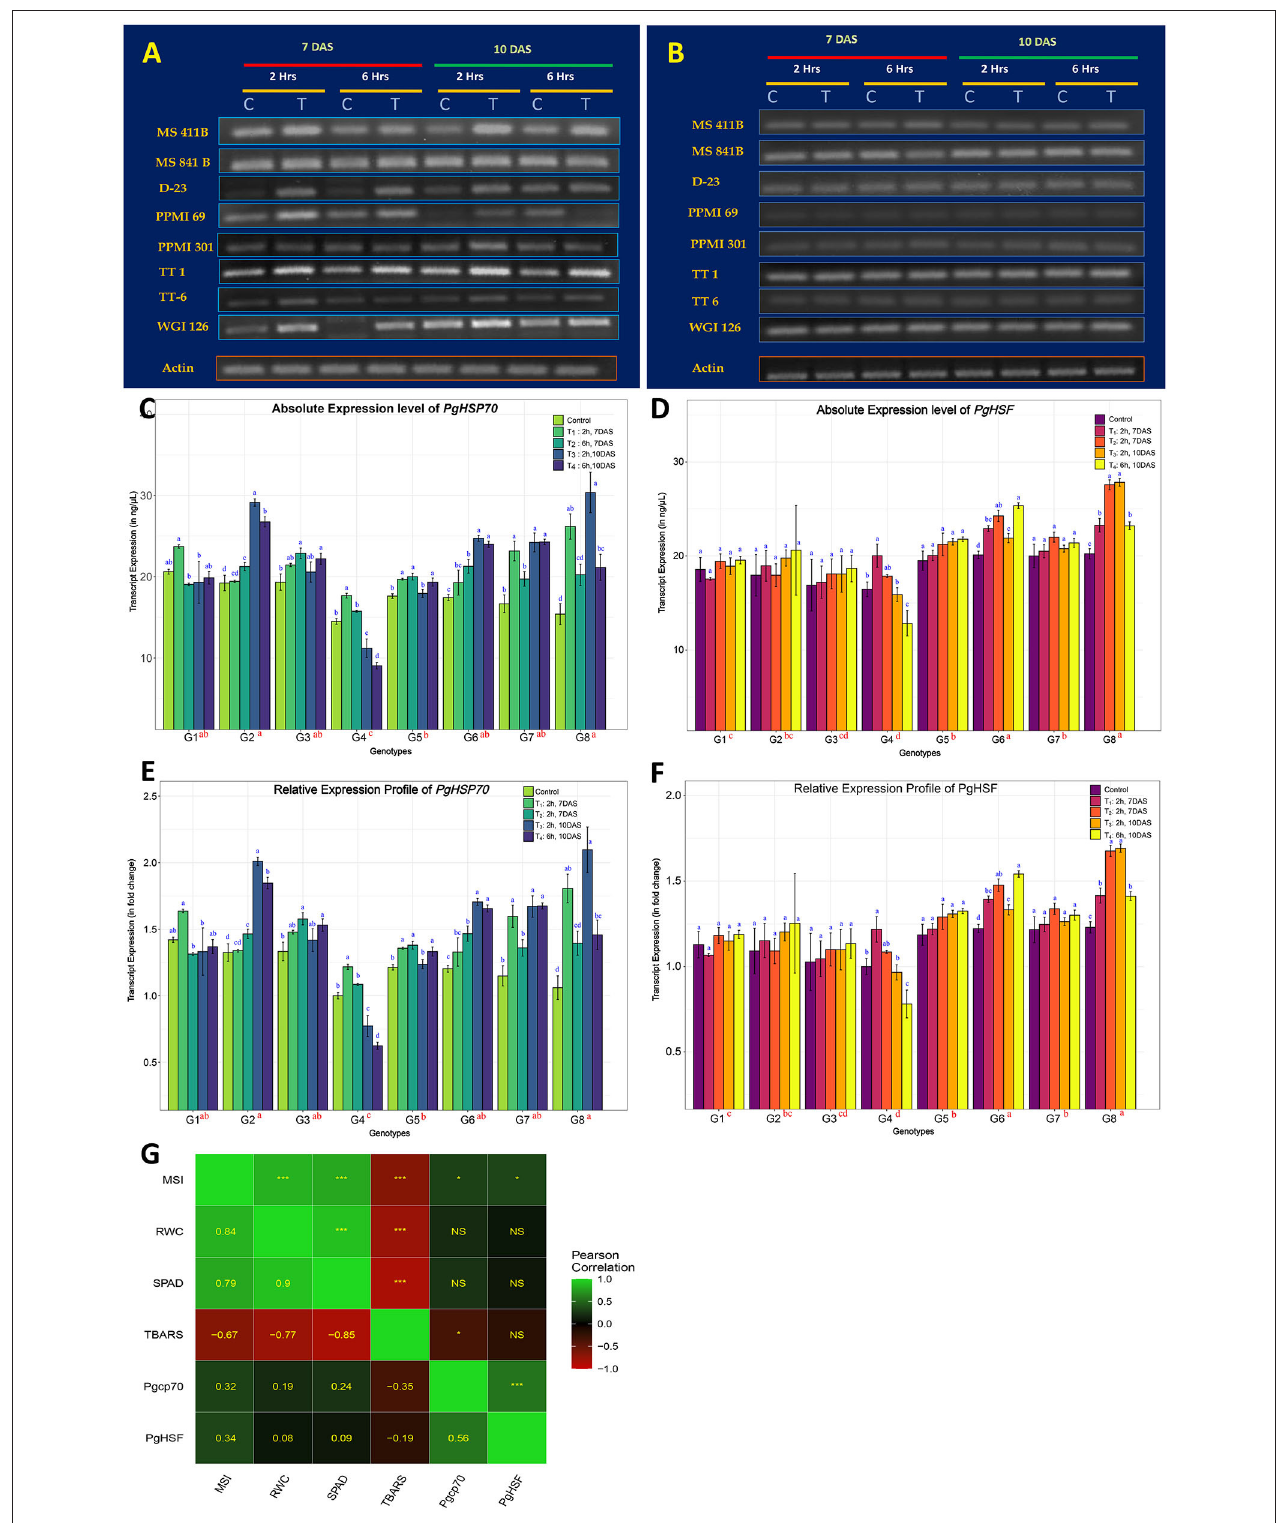
FIGURE 2 | Heat-stress induced gene expression profile of eight pearl millet genotypes for two heat-responsive marker genes. (A,B) Reverse transcription PCR (RT-PCR) gel profiles of Pgcp70 and PgHSF genes under regular plant growth (C) and those exposed to heat stress at 42 ◦ C (T) during different time periods of treatment indicated above in the seedling stage. The presented results are the representative of at least three independent biological replicates. (C,D) Comparative